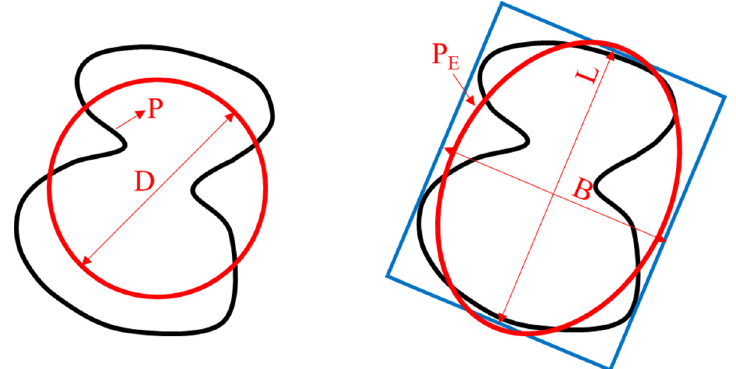
Figure 3. Illustration of aggregate feature parameters.